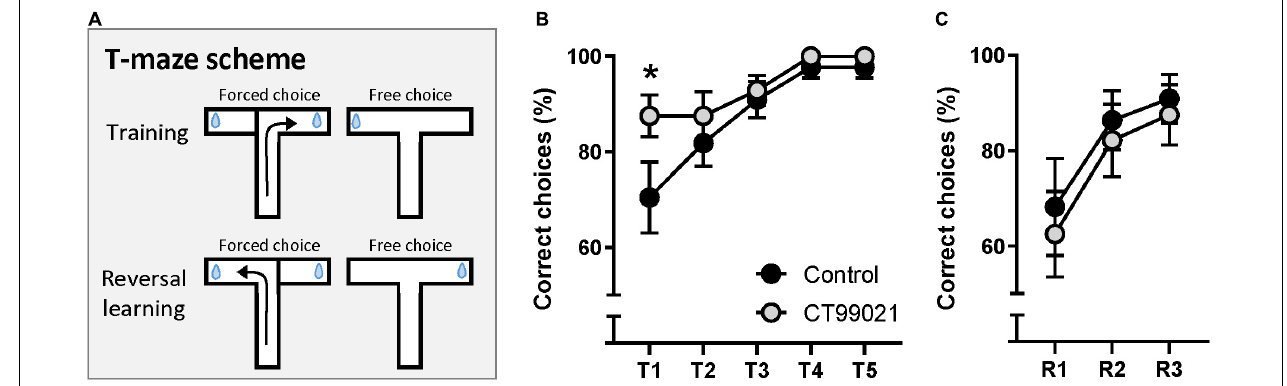
FIGURE 4 | CT99021 improves spatial learning in DMTP T-maze. (A) Schematic drawing of DMTP T-maze. The reward arm was switched for reversal learning after five days of training. Blue drop represents a reward. (B) Correct choice (%) made by the CT99021 group ( n = 11) is significantly higher compared to the vehicle group ( n = 14) on Day 1 (* p < 0.05, two-way ANOVA between vehicle and CT99021; * p < 0.05, Sidak’s post hoc test on Day 1). (C) No difference between the two groups during reversal learning is observed ( p > 0.05, two-way ANOVA). Data are presented as mean ± SEM.